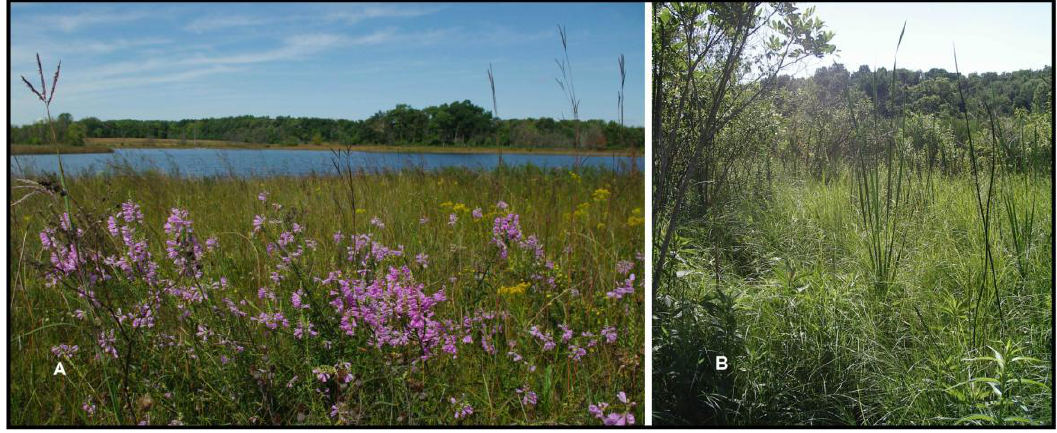
Figure 6. Houghton Lake Wetlands. Botanically rich marl flat wetlands surround much of the glacial lake ( A ) while sedge meadow ( B ) occurs over a groundwater upwelling to the east of the lake. These community types are presumed to support numerous r-d insect species at the site and are the focus of restoration